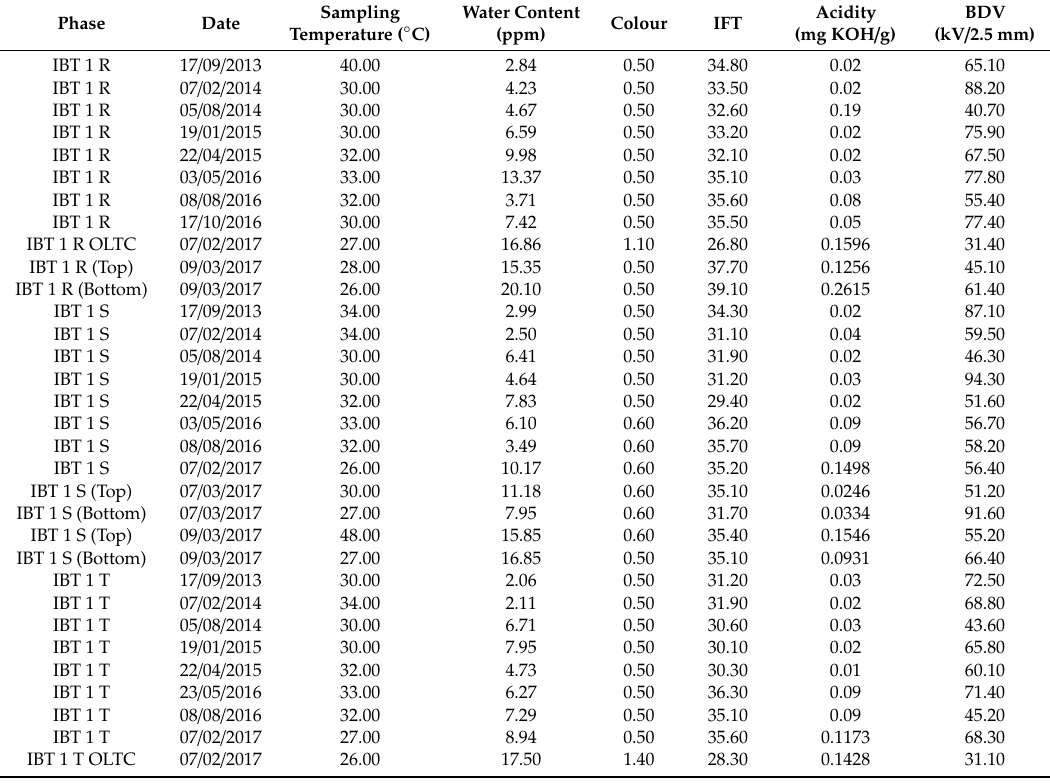
Table A8. PLN oil insulating quality